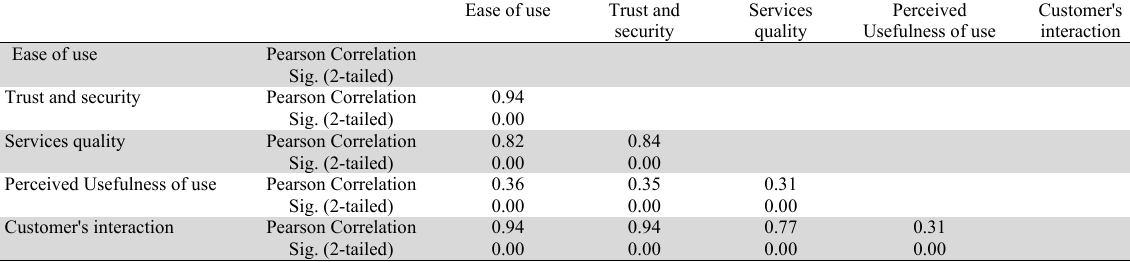
Correlation coefficient between study variables